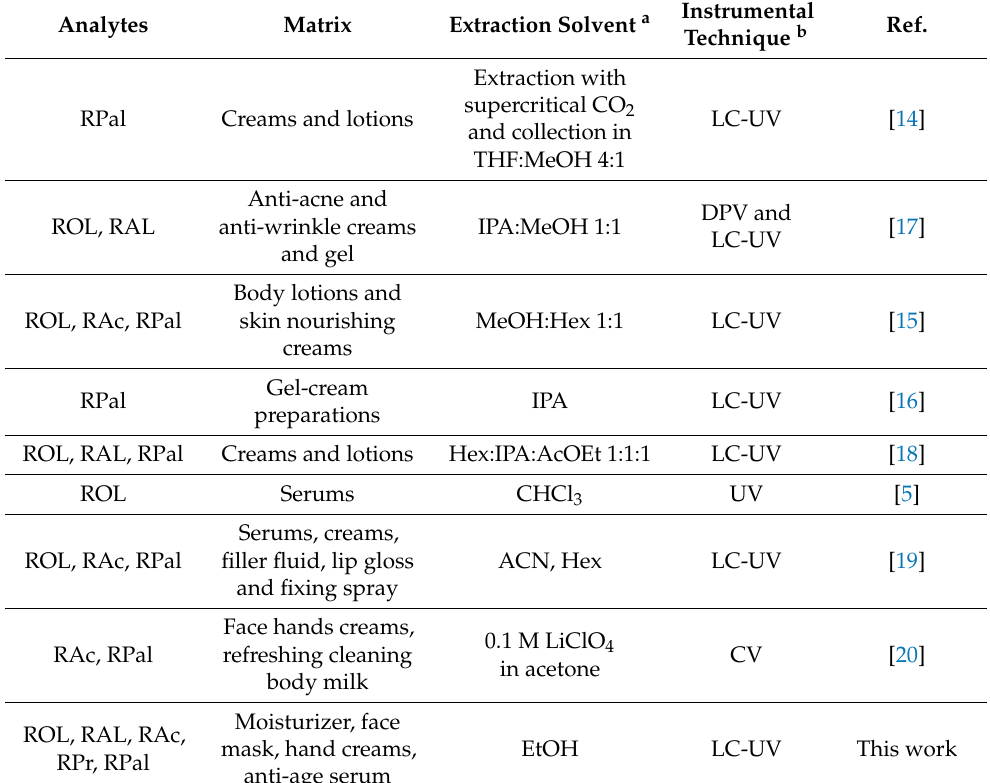
Table 7. Comparison of the proposed approach with other methods for the determination of retinoids in cosmetic products. Analytes Matrix Extraction Solvent a